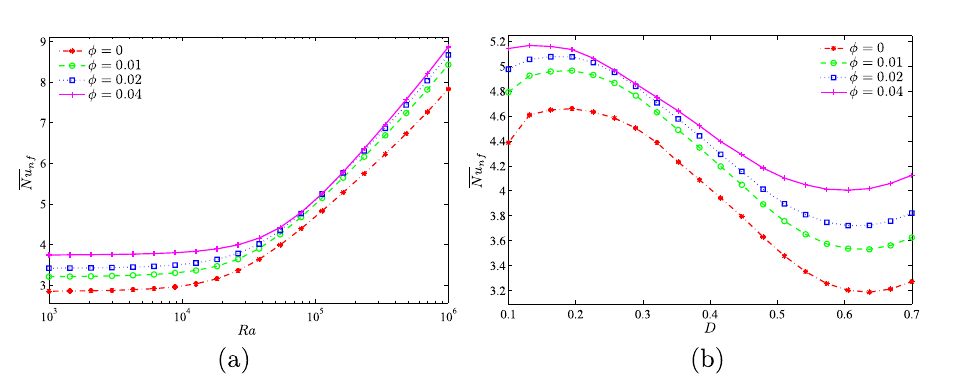
Figure 11. Variation of local Nusselt number interfaces with ( a ) Y and ( b ) X for different φ at Ra = 10 5 , Ha = 15, k w = 0.76 and D = 0.3.